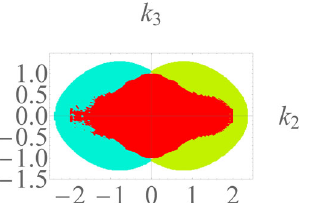
Fig. 9 Comparison of the simulated tidal region obtained from the Hopf link nodal knot circuit with the theoretical tidal region and drumhead regions. Region of divergent node-averaged impedance (red) in the parameter space of a simulated Hopf circuit, which agrees very well with the tidal region of the Hopf link nodal knot metal (NKM). The cyan and green regions are the surface projections of the bulk nodal structure (conventional drumhead regions), which are totally different from the